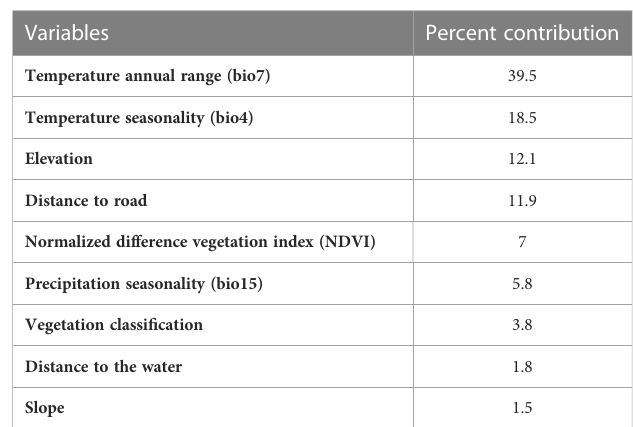
TABLE 1 Contribution rate of